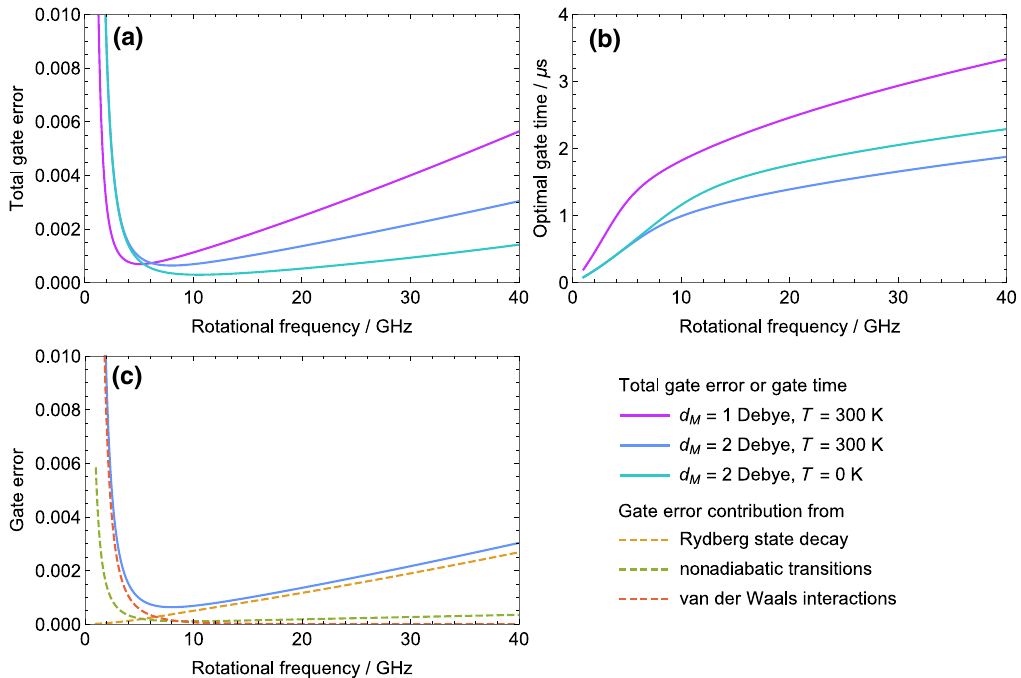
FIG. 3. Gate performance as a function of the rotational frequency of the molecule, for two different molecular dipole moments ( d M ) and environmental temperatures, T . We assume an atom-molecule separation of 1 μ m with an uncertainty of 0.2 μ m. (a) Total gate error when the gate time is optimized. (b) Optimum gate time. (c) Error contributions from three different sources when d M = 2 Debye and T = 300